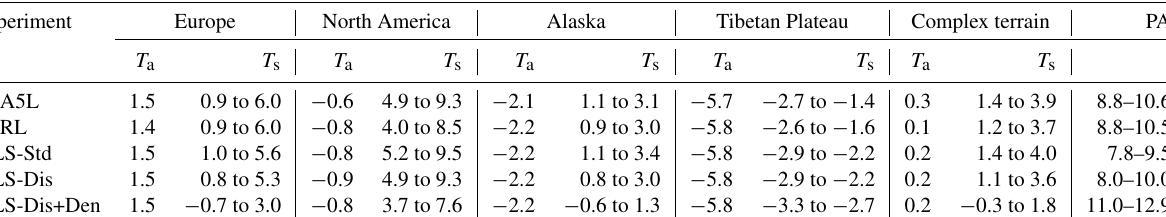
Table 2. The wBias of near-surface air temperature ( T a , ◦ C), soil temperature ( T s , ◦ C) for four layers in DJF at a grid scale, and permafrost area (PA, 10 6 km 2 ) estimated from the mean annual ground temperature of the fourth soil layer (1.89m).